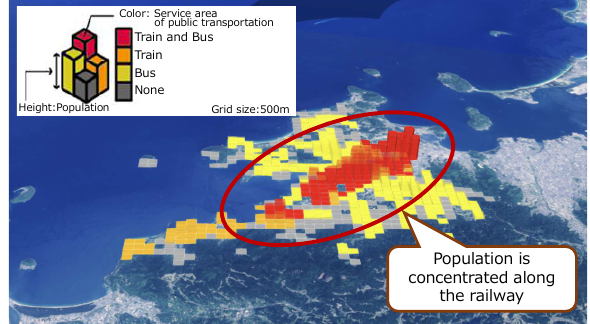
2.2.1 Cross Visualization: Cross Visualization in 3D yields two types of information - height and color - represented together on the map. Figure 3 shows an example of cross